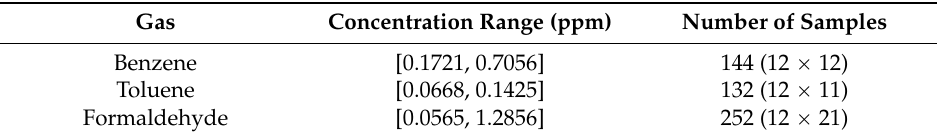
Table 2. Concentration of the target gas.